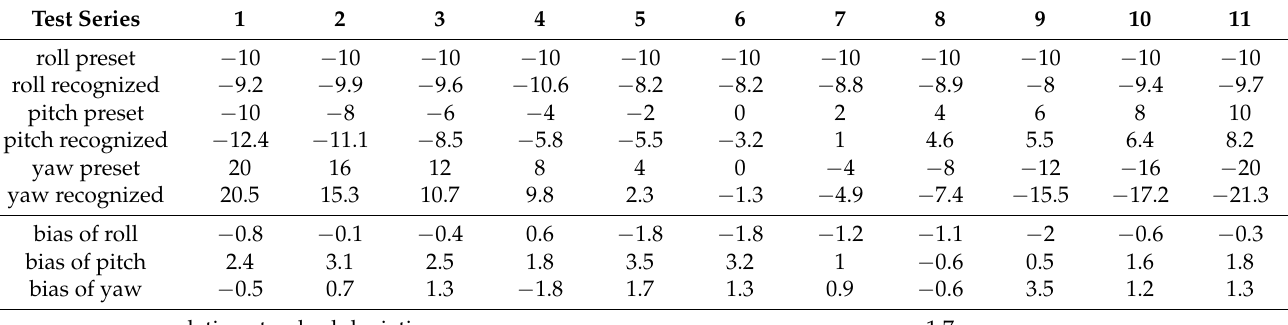
Table 1. Preset; detection values; and deviations of roll, pitch, and yaw of experiment 1 ( ◦ ).